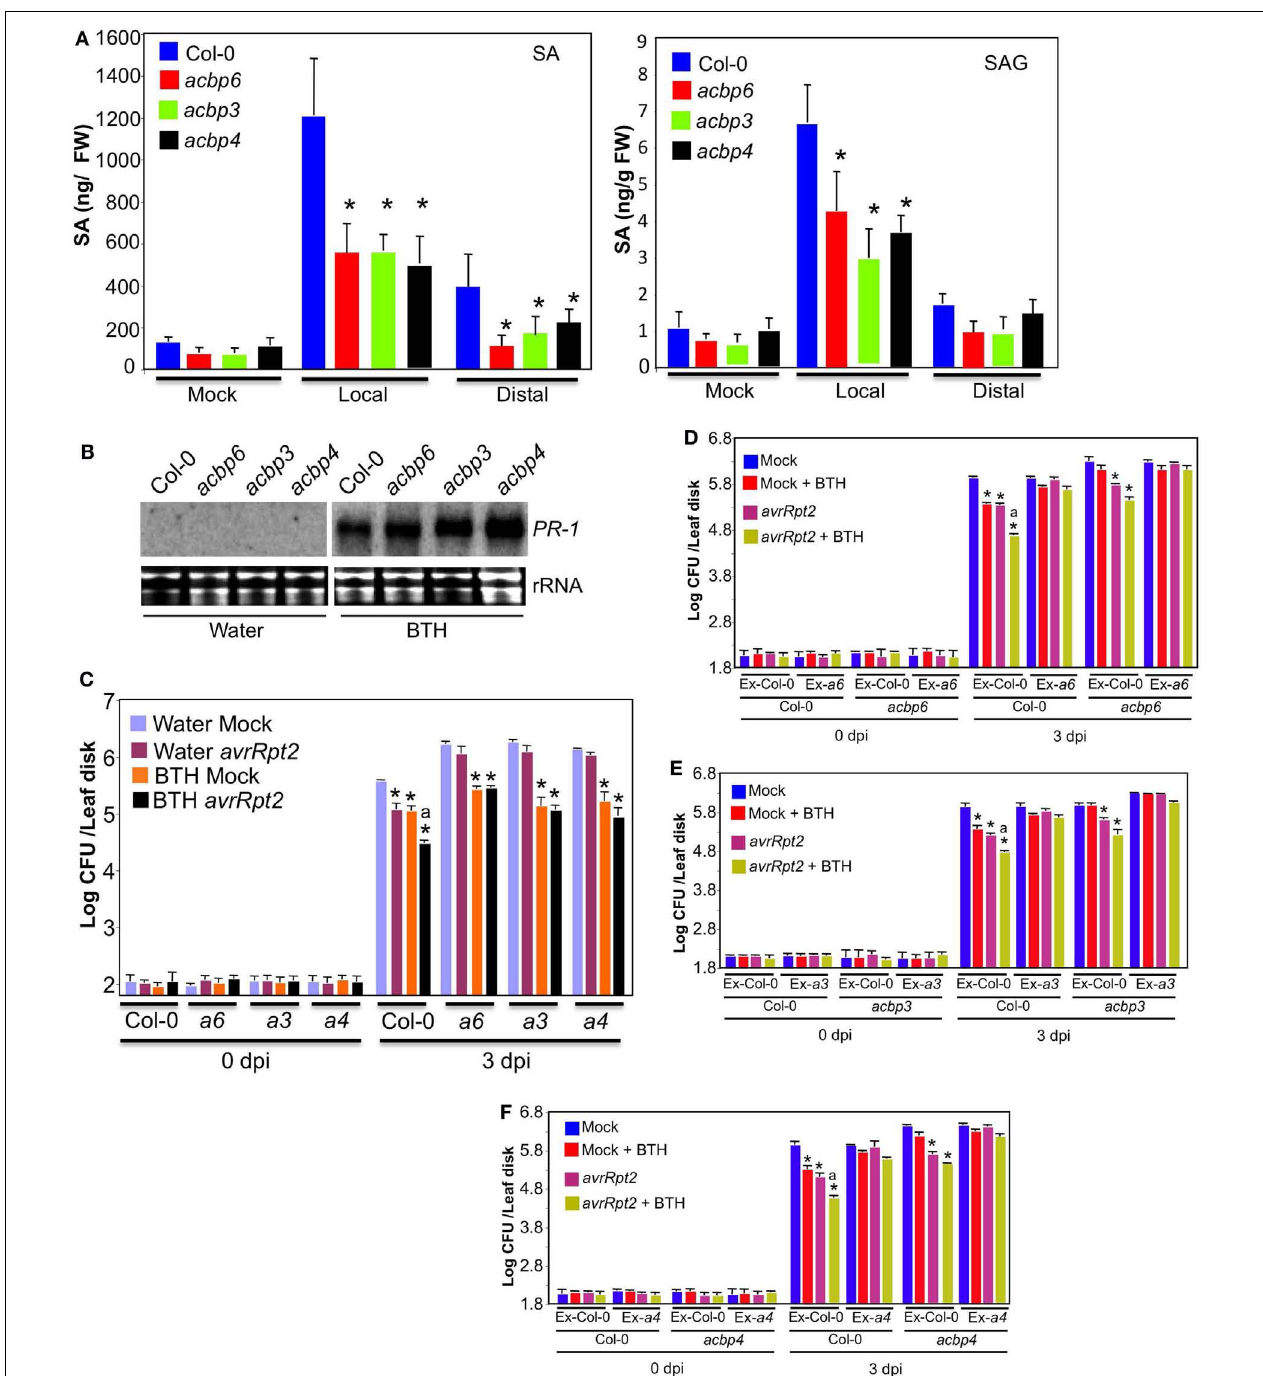
experiment was repeated twice with similar results. (C) SAR response in Col-0 and acbp plants pretreated with water (purple and pink bars) or the SA analog BTH (orange and black bars) for 48h prior to mock (purple and orange bars) or avr (pink and black bars) inoculation.The error bars represent SD ( n = 4). Asterisks denote statistical differences from water and mock treated plants of corresponding genotype ( t -test P < 0.001). Statistical difference from BTH and mock treated plants is indicated by “a” ( P < 0.001).The experiment was repeated three times with similar